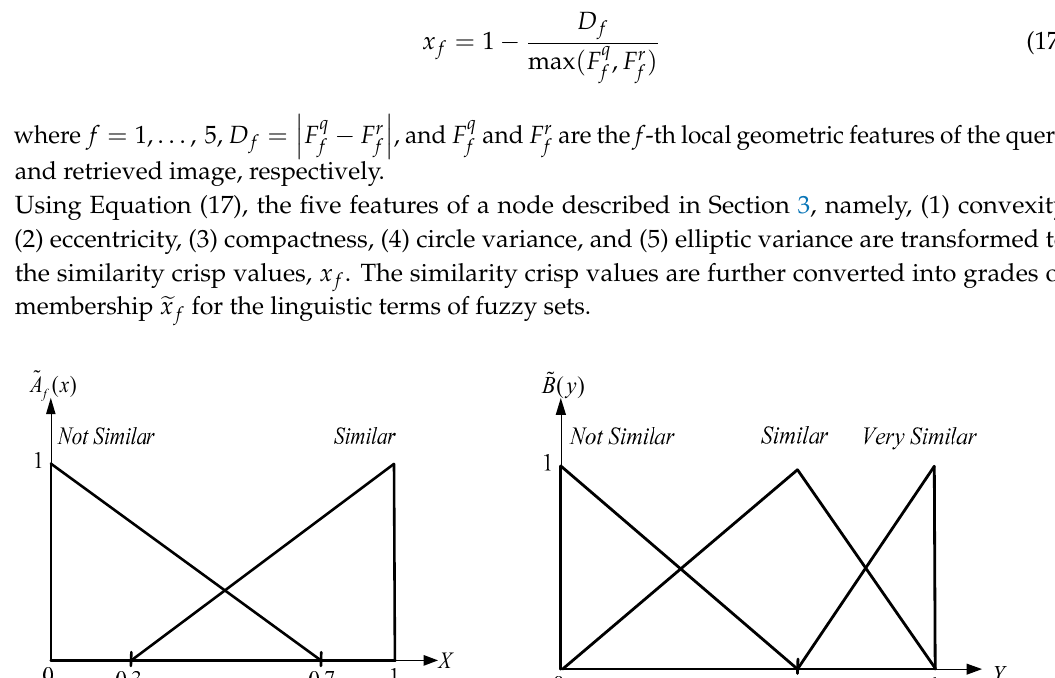
1 , x 2 , . . . , x 5 ; ( b ) Output: y